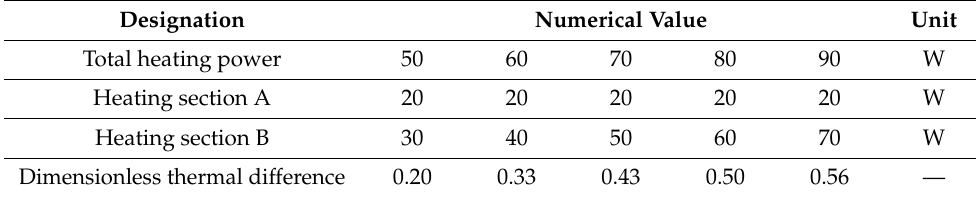
Table 4. Heating power configuration of heating section A and B under the condition of non-uniform heat